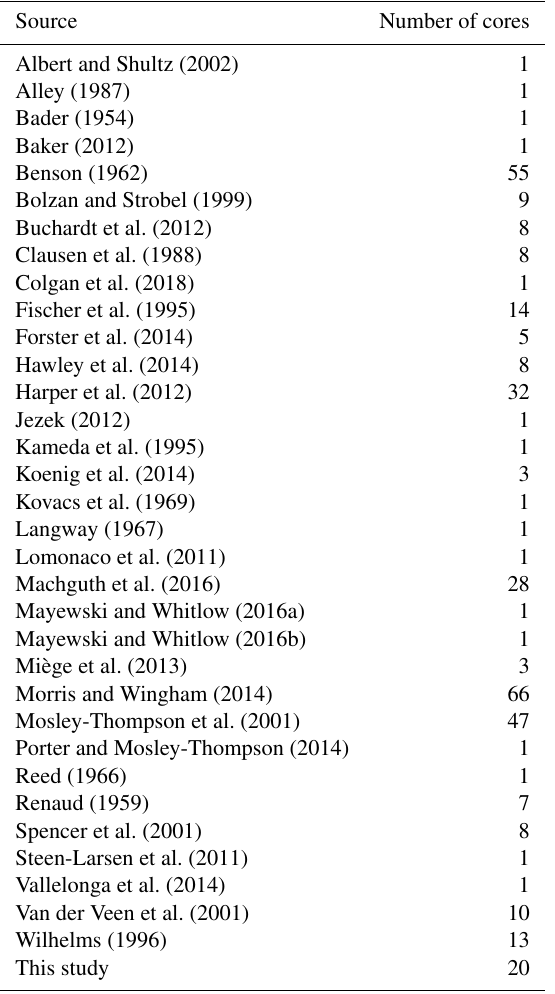
Table 1. List of the publications presenting the firn cores used in this